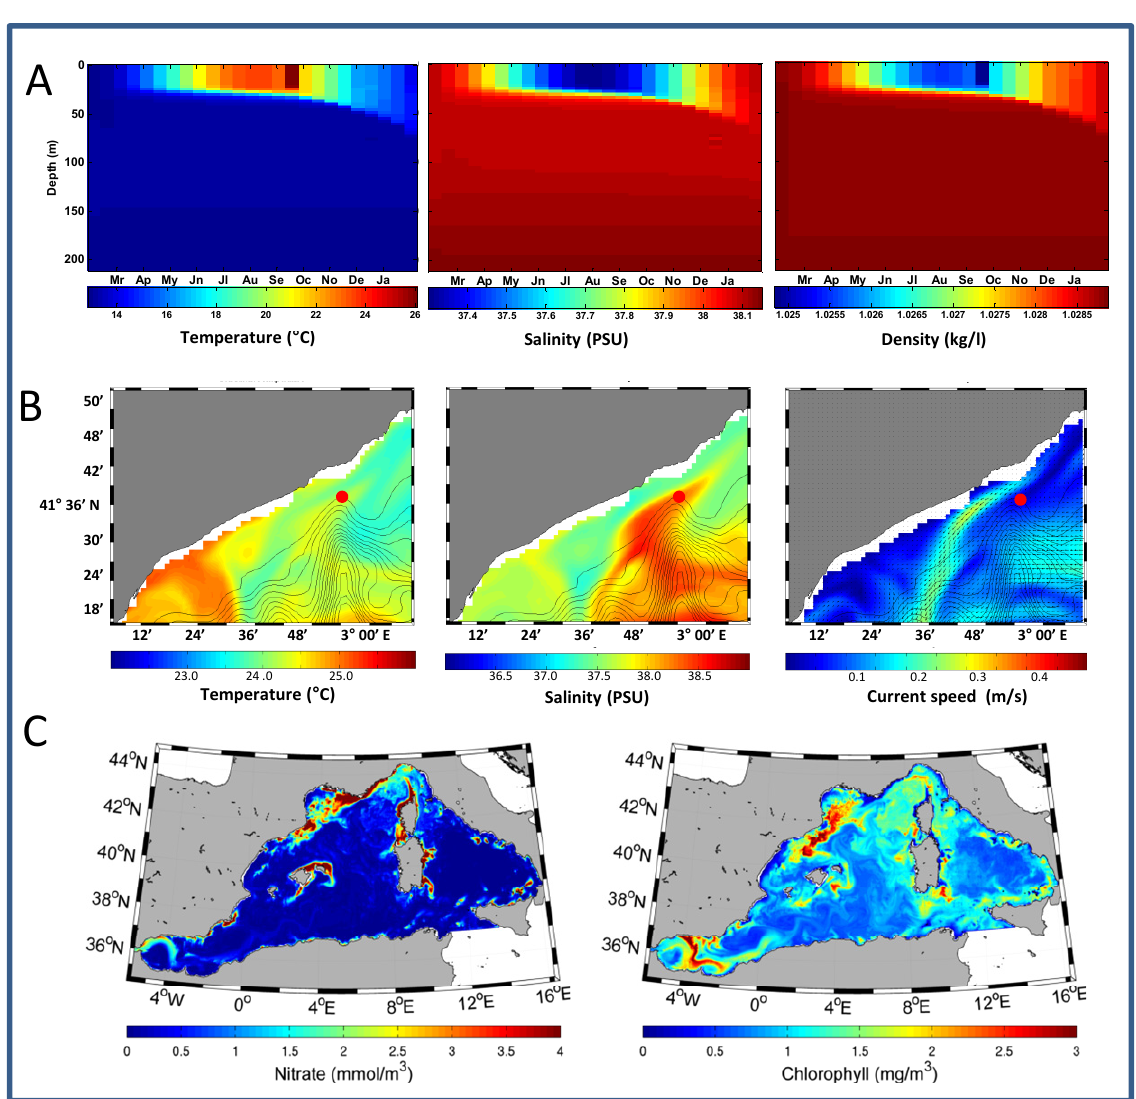
Figure 8. Examples of simulation outputs obtained assimilating OOCS data into numerical models operating at different space scales. (A) 1DV model simulations of water temperature, salinity, and density at the observation station for a whole year, imposing sea surface temperature and salinity provided by OOCS as boundary conditions; (B) simulations of high resolution sea surface temperature, salinity and velocity fields using the 3D model for the Blanes Canyon. The red circle over the canyon head indicates the location of the OOCS station; (C) simulations of sea surface nitrate concentration and chlorophylls concentration covering a wider western Mediterranean domain using the 3D model for the Western Mediterranean